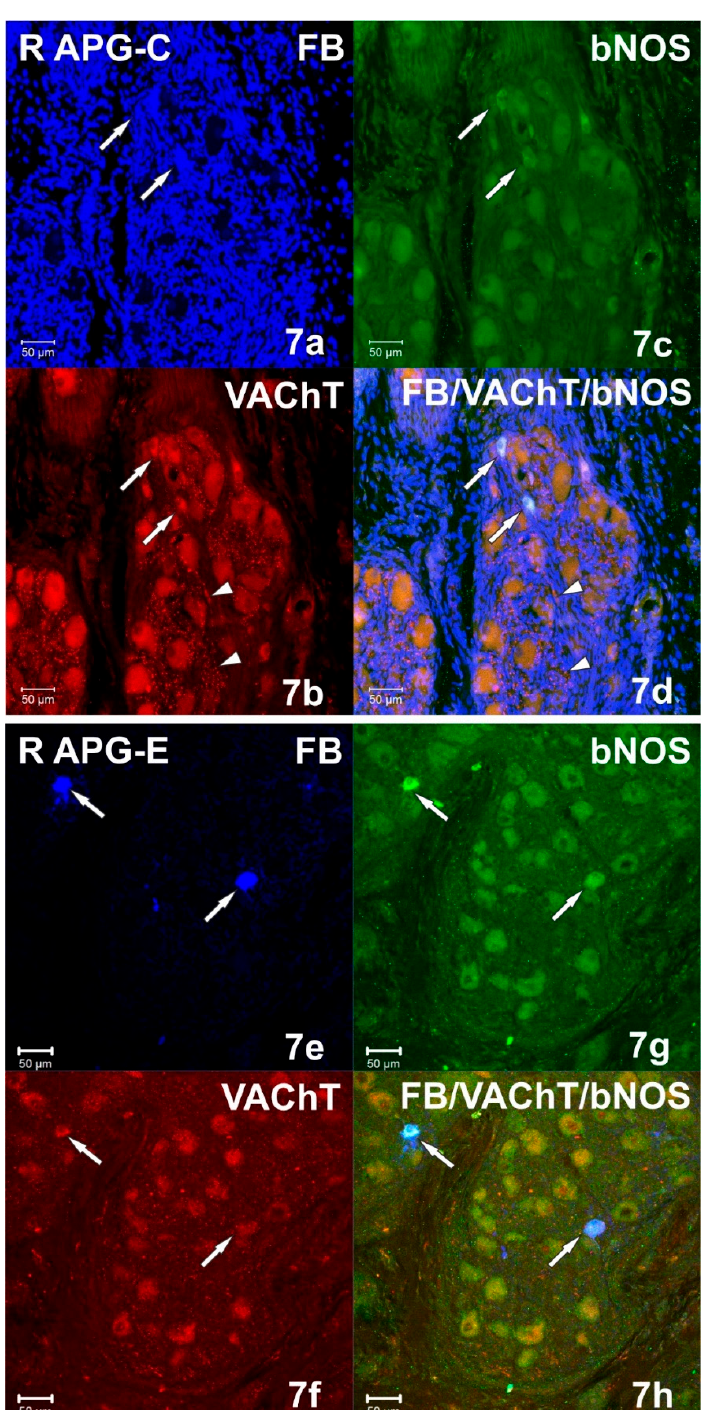
Figure 7. ( a – d ) Confocal laser scanning microscope images showing a section of the right (R) APG from the control (C) group. Arrows indicate FB+ ( a ) vesicular acetylcholine transporter (VAChT)-IR ( b ) neurons, but not containing bNOS ( c ). The arrowheads indicate numerous VAChT-IR fibers with a transverse course ( b , d ). The images were taken from blue, green and red fluorescent channels. Blue, green and red channels were digitally superimposed. Scale bar = 50 µm. ( e – h ) Confocal laser scanning microscope images showing a section of the right (R) APG from the experimental group. Arrows indicate FB+ neurons ( e ) immunoreactive against bNOS ( g ) but VAChT negative ( f ). The images were taken from blue, green and red fluorescent channels. Blue, green and red channels were digitally superimposed. Scale bar = 50 µm.